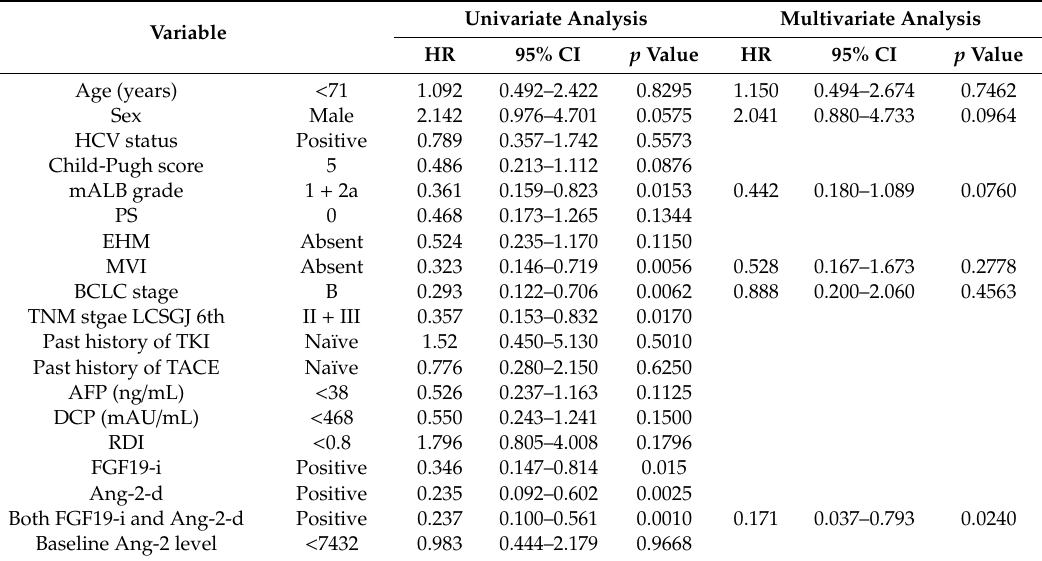
Table 3. Association between clinical factors and levels of biomarkers and progression-free